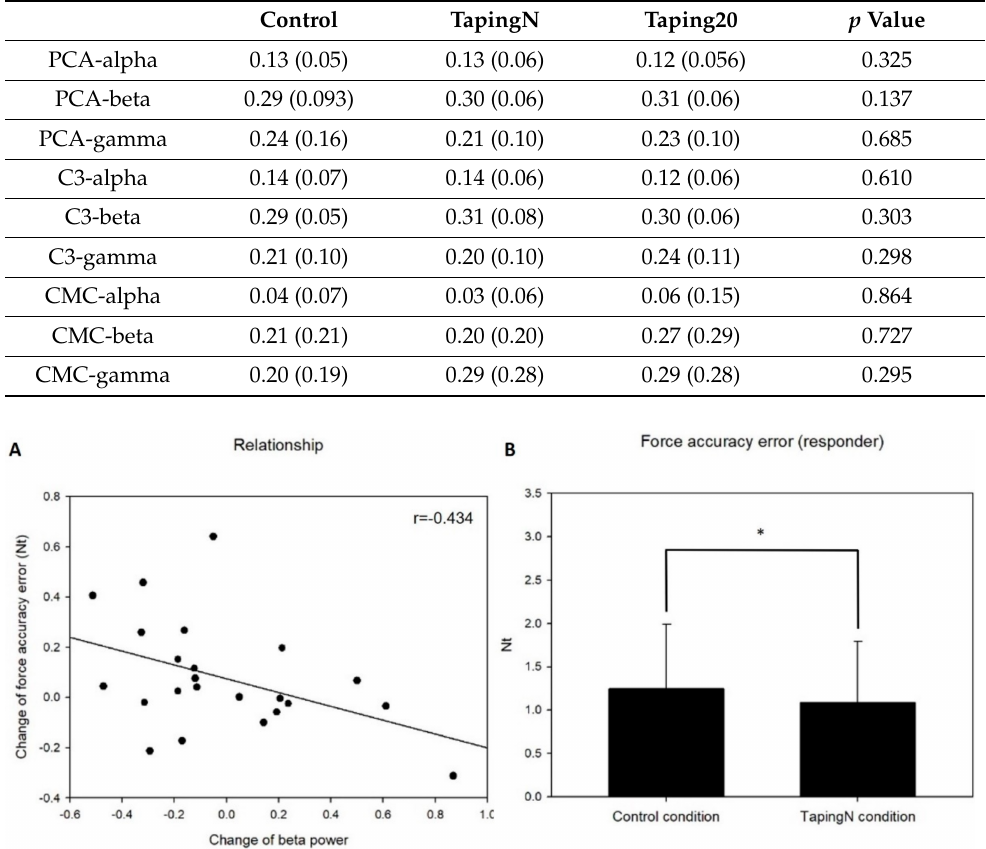
Figure 3. ( A ) Change of force accuracy error had a negative moderate correlation with change of beta power in the tapingN condition. ( B ) The responders showed less force accuracy error (mean ± standard deviation) under the tapingN condition. * indicates significant difference between conditions ( p <